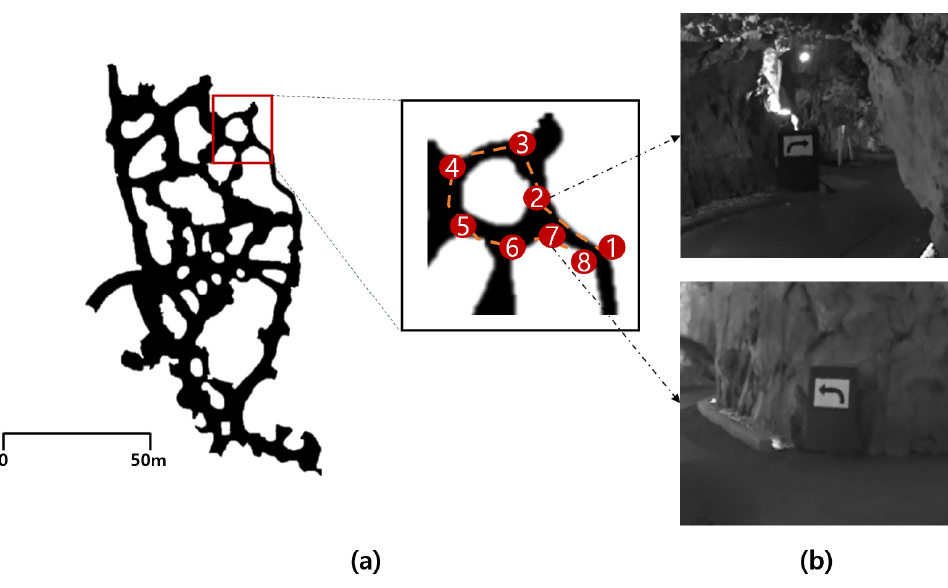
Figure 5. Conceptual diagram of the ( a ) field experiment area and ( b ) road signs installed in the underground mine.